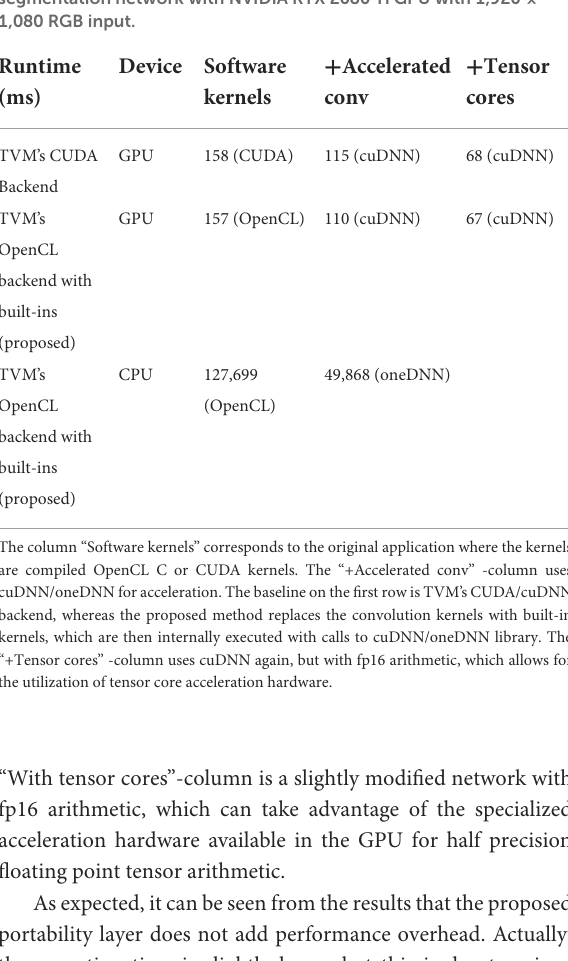
demonstrator utilized TVM’s OpenCL runtime to launch the kernels.